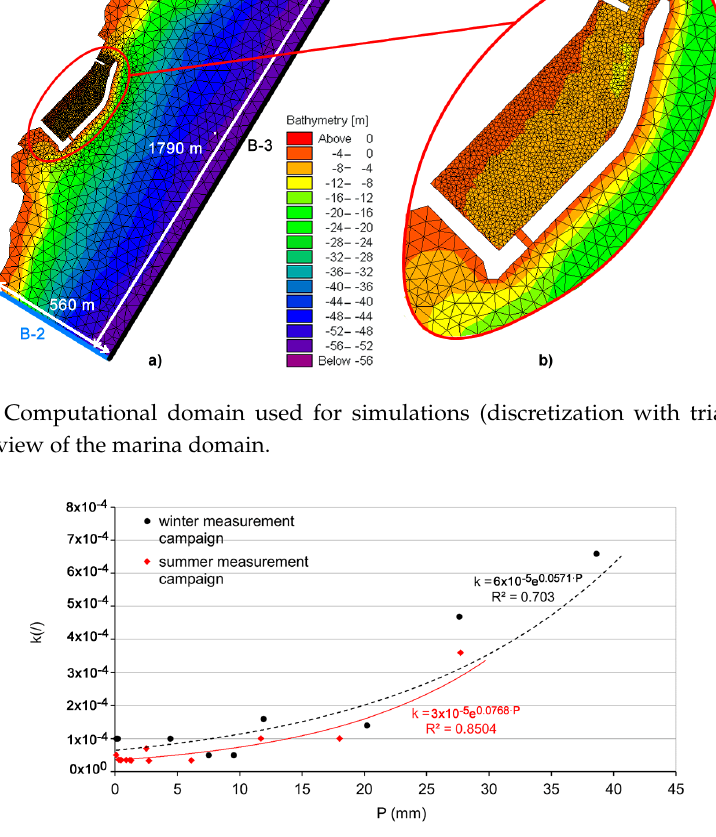
Figure 9. Correlation between the proportionality coefficient k and precipitation P (mm) used for source inflow rate calculation.